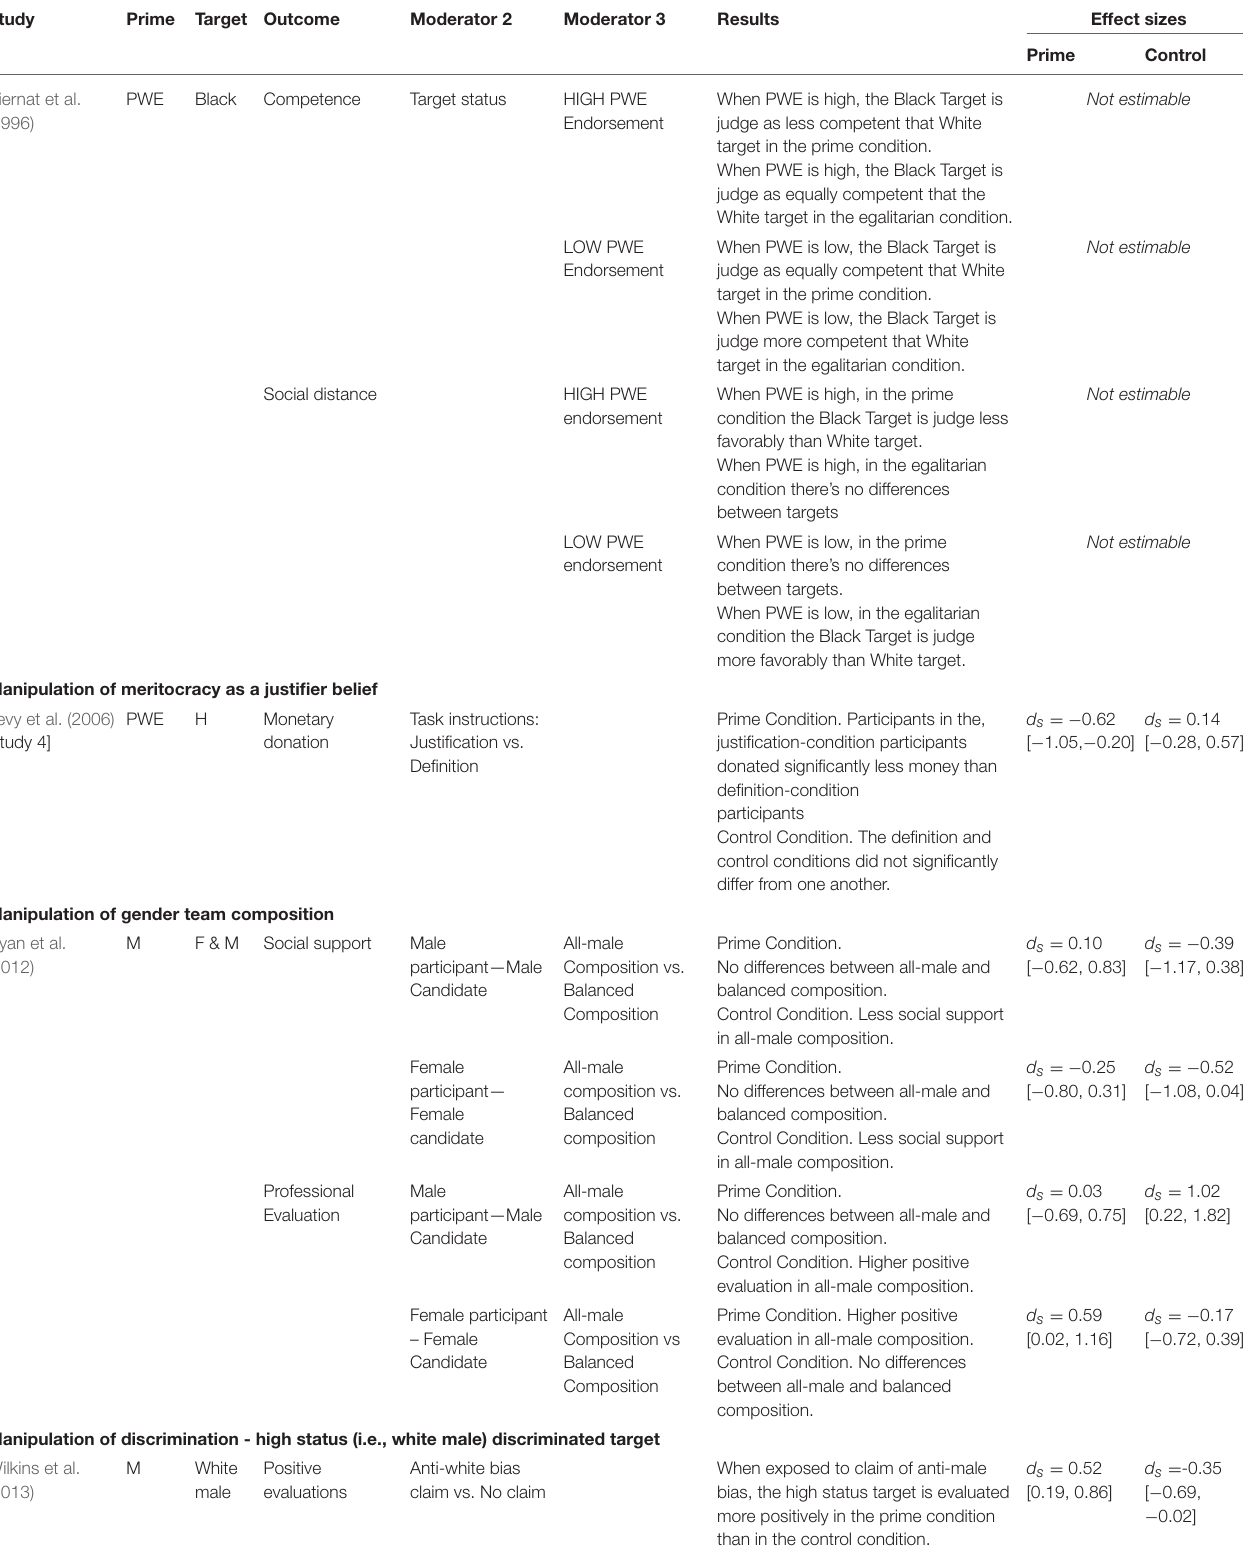
TABLE 4 | Summary of studies related with Moderators of the relationship between Meritocracy and Intergroup Attitudes and Behaviors.